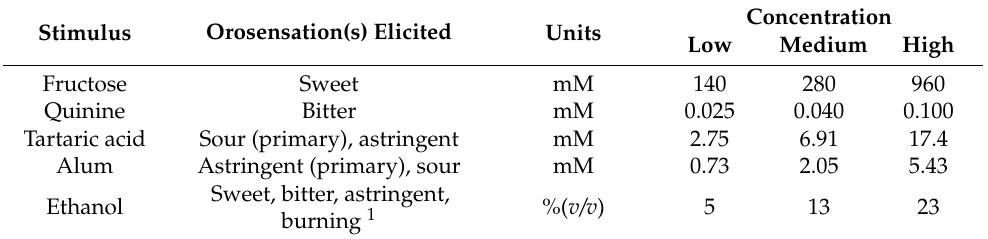
Table 1. Orosensory stimuli and concentrations used in taste–taste